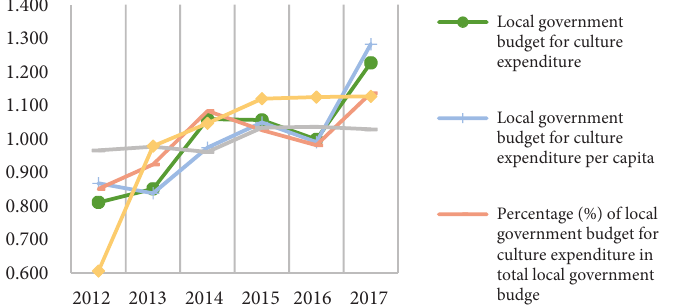
Figure 2. Cultural and administration